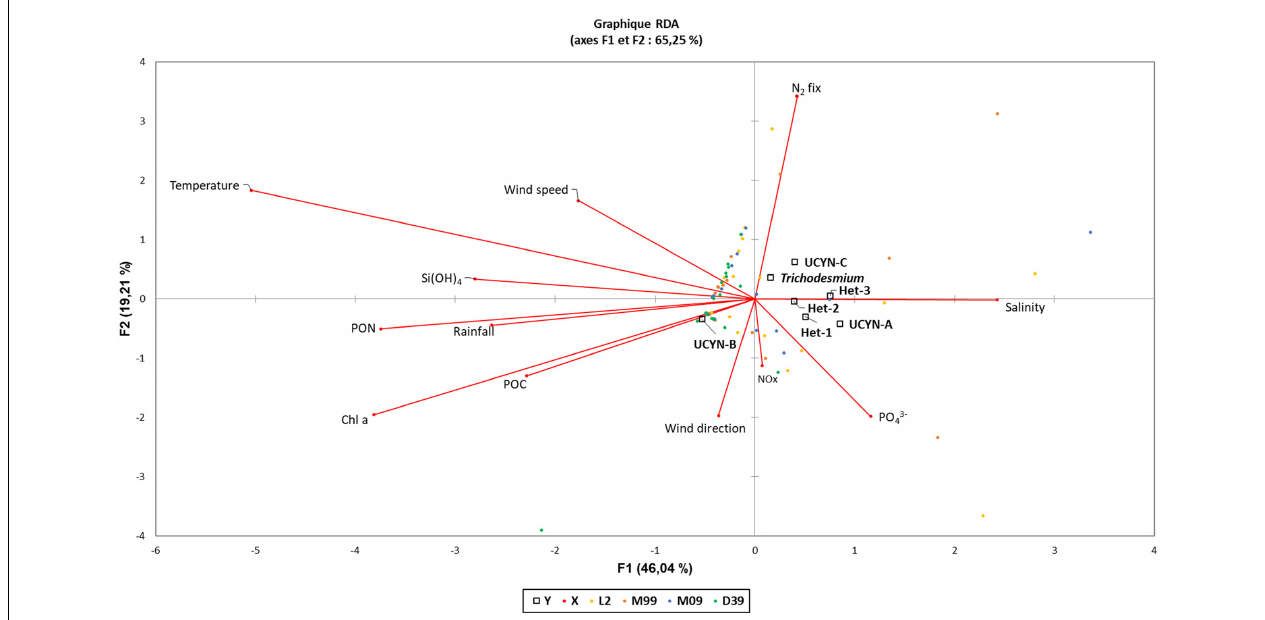
FIGURE 5 | Redundancy analysis (RDA) biplot of abundance of each diazotroph phylotype targeted in this study (UCYN-A, UCYN-B, UCYN-C, Trichodesmium , Het-1, Het-2, and Het-3) and environmental parameters [sea surface temperature, Si(OH) 4 , PON, POC, rainfall, Chl a, wind direction, wind speed, NOx, PO 43 − , Salinity, and N 2 fixation rates]. Points represents one of all diazotrophic phylotypes targeted at a specific time-point ( n = 71), each diazotrophic phylotype are represented by squares and environmental parameters are indicated by lines with arrows.